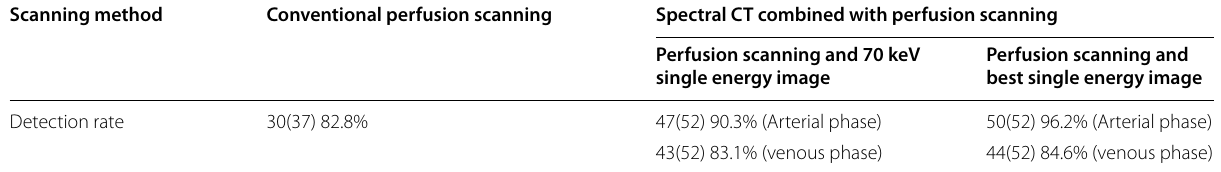
Table 2 Comparison of detection rate between spectral CT combined with perfusion scanning and conventional perfusion scanning Scanning method